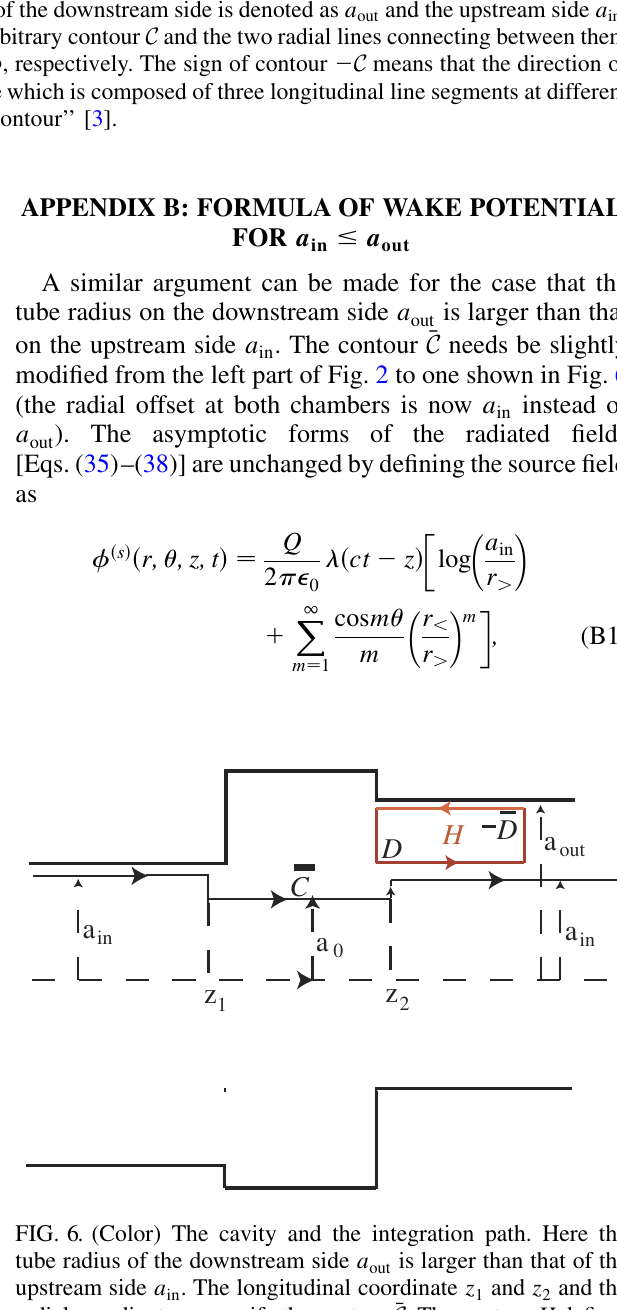
and the upstream side a . out in